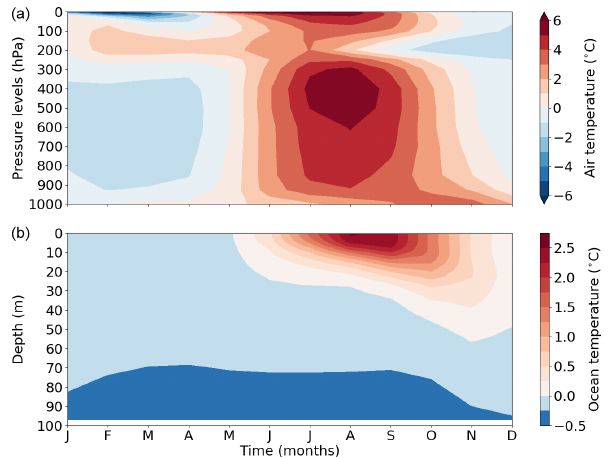
Figure 8. Annual evolution of LIG–PI temperature anomalies aver- aged over the Arctic region (60–90 ◦ N), as a function of pressure in the atmosphere (a) and depth in the ocean (b) . Below 100m depth, the ocean temperature anomaly is negative and ranges between 0 and − 0 . 53 ◦ C.